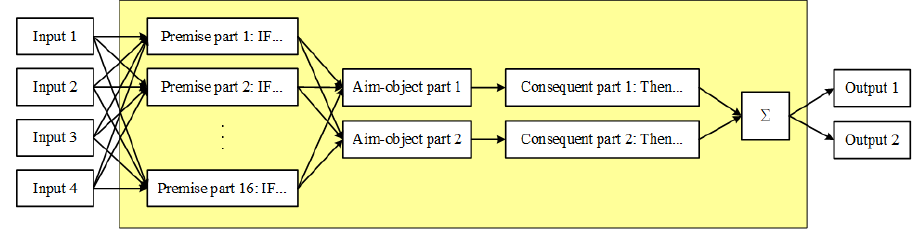
Fig. 4. The proposed ACFIS model in the